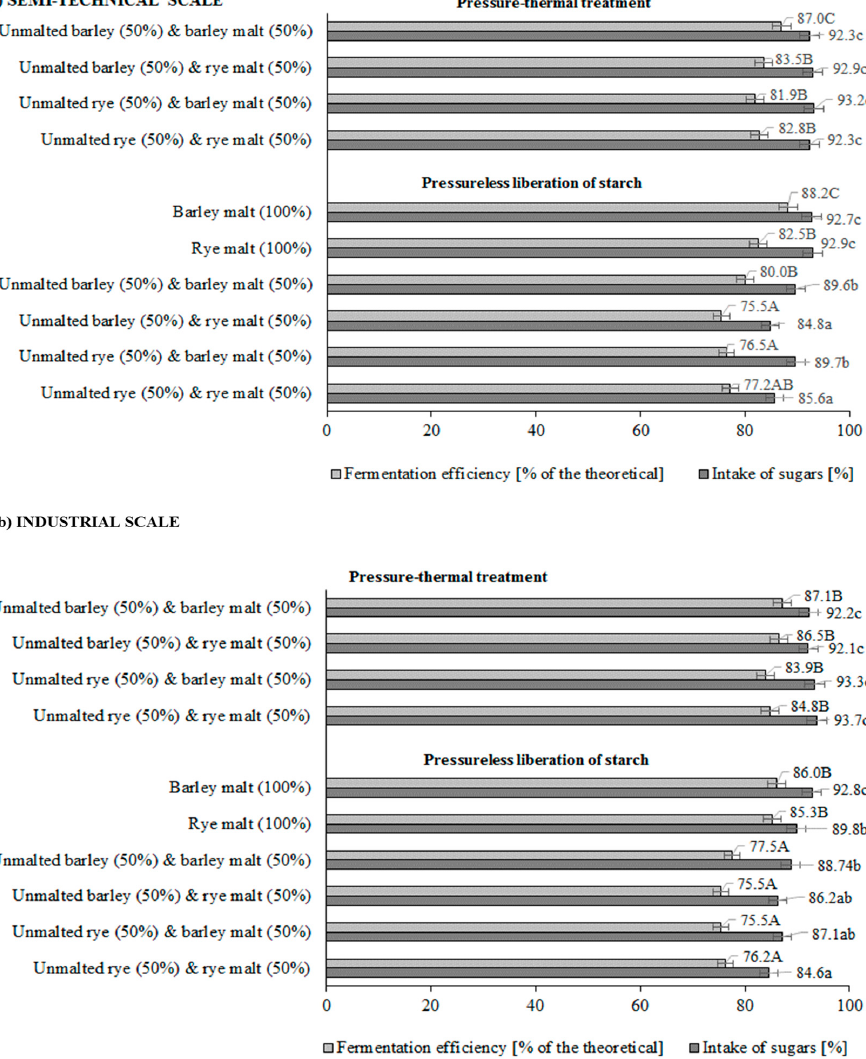
Figure 1. Fermentation factors of distillery mashes prepared from unmalted rye or barley grains and cereal malts. Different letters indicate significant differences ( p < 0.05) between mean values of intake of sugars (lowercase letters), fermentation efficiency (capital letters).